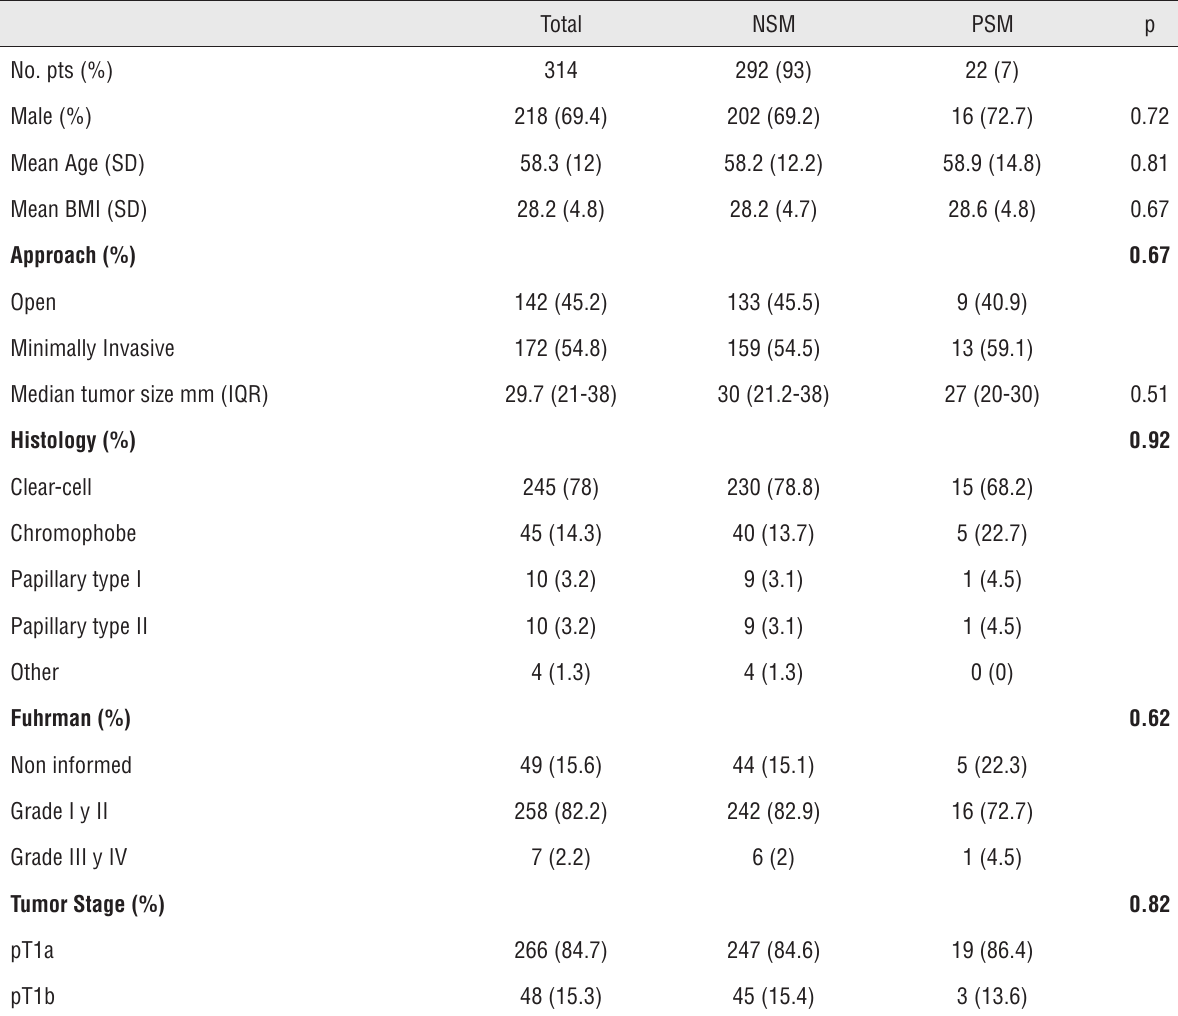
Table 1 - Baseline